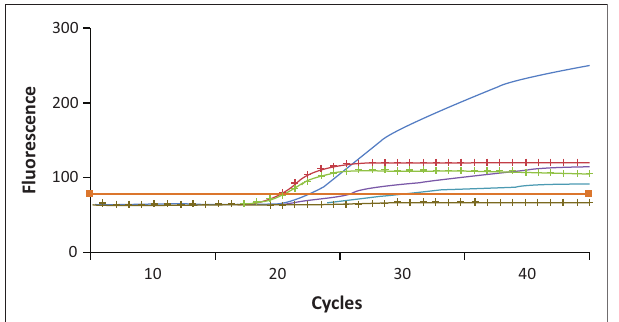
FIGURE 3: Amplification curves showing the analytical sensitivity of one sample. Green: 100 % homozygous mutant DNA; red: 20 % mutant with 80 % wild-type DNA; blue: 0.1 % mutant DNA in 99.9 % of wild-type DNA.